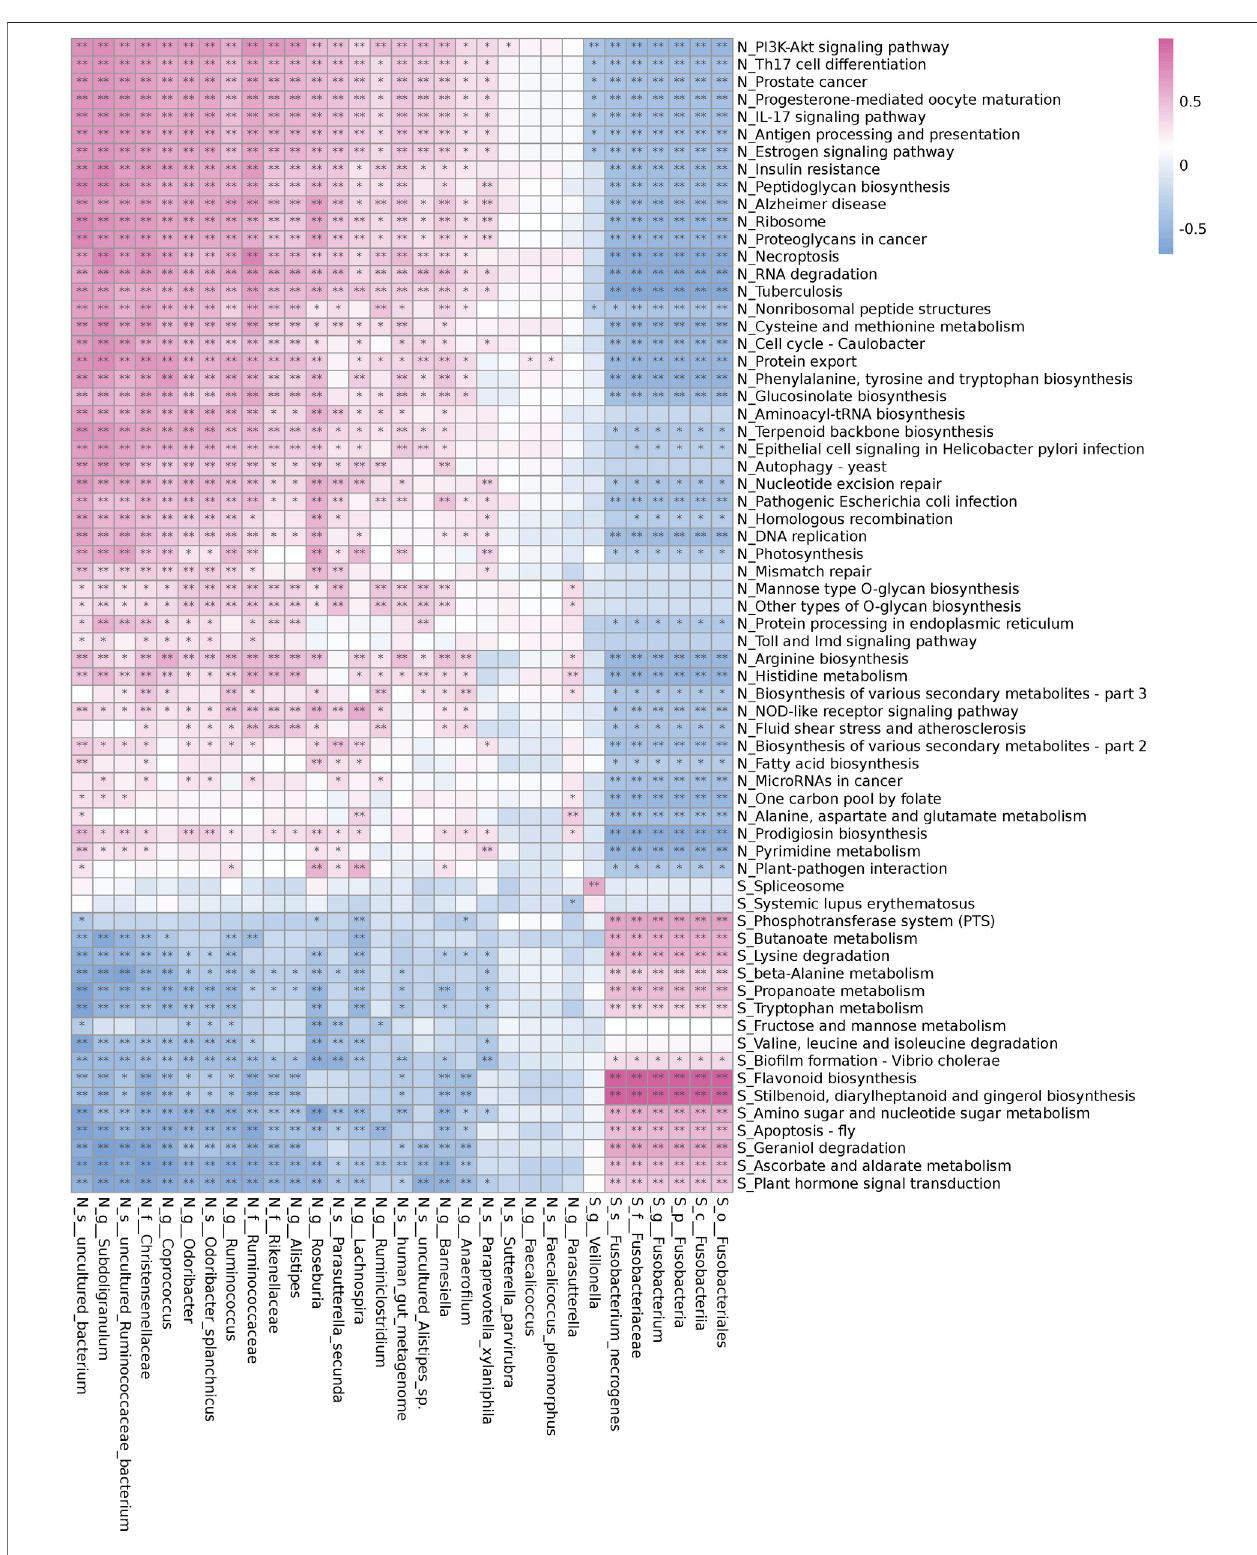
FIGURE4| CorrelationofdifferentbacterialabundanceandKyotoEncyclopediaofGenesandGenomes(KEGG)metabolicpathwaysinthecontrols(GroupN)and the renal uric acid stone patients (Group S). The red cell indicates a positive correlation and the blue cell indicates a negative correlation. Stars indicate the degree of signi fi cant correlations (*, p < 0.05,**, p < 0.01).